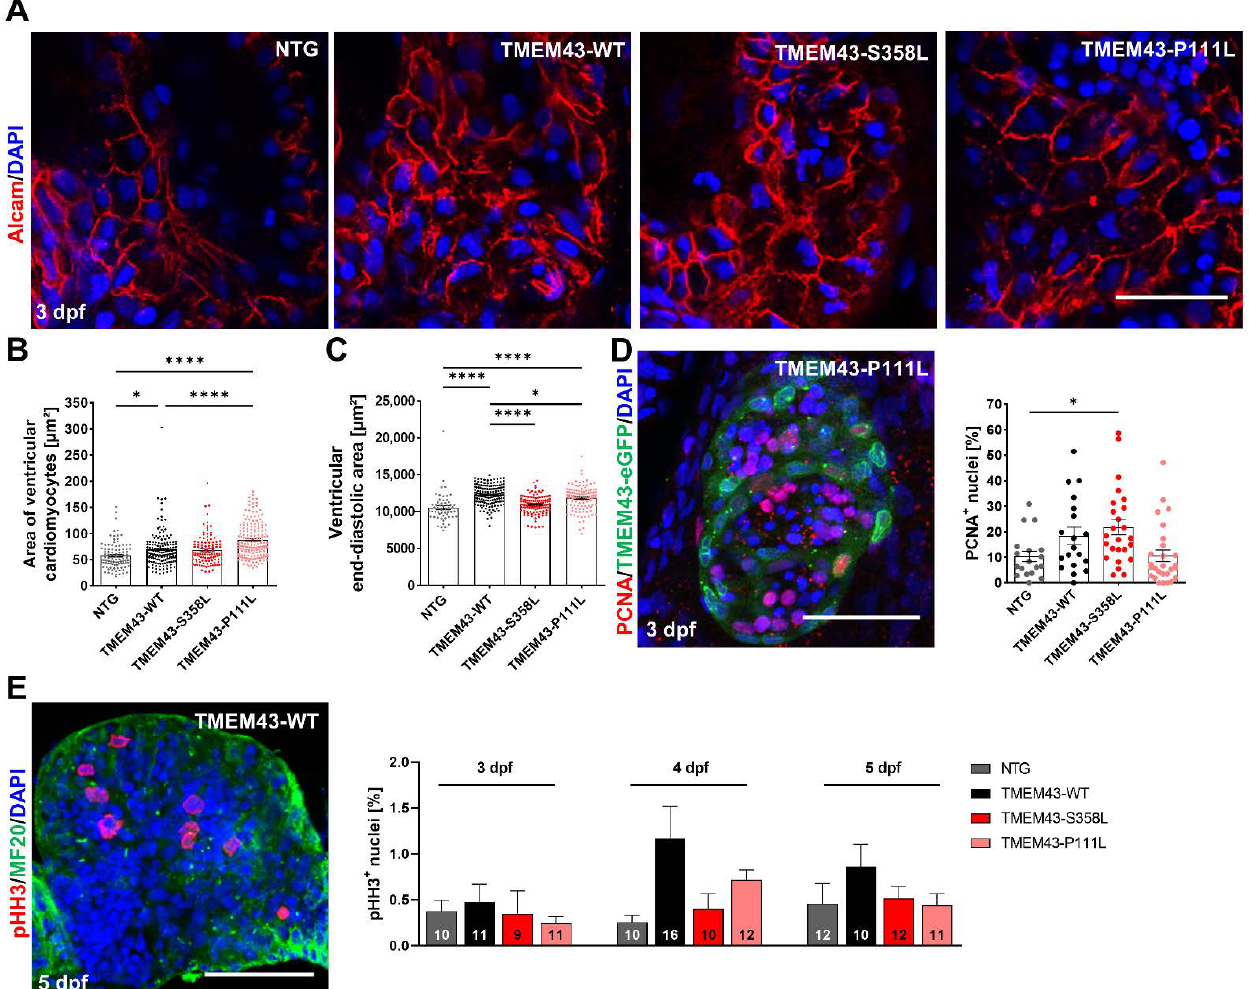
Figure 4 . Cardiac overexpression of stably folded TMEM43 leads to hypertrophic ventricular growth, but unchanged proliferation capacity in embryos. ( A ) Confocal maximum intensity projec- tions of 3 days post fertilization (dpf) hearts immunostained with DAPI (blue) and Alcam (red) to highlight plasma membranes. Scale bar = 30 µm. ( B ) Quantification of cardiomyocyte (CM) area represented in ( A ) reveals larger CMs in TMEM43-WT and TMEM43-P111L compared to non-trans- genic control (NTG) and TMEM43-S358L individuals (n ≥ 10 hearts per genotype). ( C ) Quantifica- tion of ventricular end-diastolic area shows the mean area of three individual sections of each fish from a time series of the embryonic cardiac cycle. Significantly increased end-diastolic ventricular areas were measured in TMEM43-WT and TMEM43-P111L compared to NTG and TMEM43-S358L individuals. ( D ) Representative confocal maximum intensity projection of a heart immunostained with PCNA (red), GFP (green), and DAPI (blue) at 3 dpf. Scale bar = 50 µm. In the graph, individual data points represent the percentage of PCNA + nuclei in the ventricle of each fish (n ≥ 18 individuals per genotype). A slightly increased proliferation rate was observed in the TMEM43-S358L trans- genic line compared to NTG. ( E ) Representative maximum intensity projection of a dissected heart immunostained with pHH3 (red), MF20 (targeting MYH1E; green) and DAPI (blue) at 5 dpf. Scale bar = 50 µm. The graph displays the mean percentage of pHH3 + cell nuclei for each genotype at 3 dpf, 4 dpf, and 5 dpf. The number of analyzed hearts per condition are indicated at the bottom of the columns. ( B – E ) For all graphs, significance was determined by one-way ANOVA with Bonfer- roni’s multiple comparison test, * p ≤ 0.05, **** p ≤ 0.0001. Error bars correspond to SEM. To further determine the effect of TMEM43-WT and TMEM43 variants on adult hearts, we examined heart morphology in >5-month-old fish. Male and female TMEM43 transgenic zebrafish survived until adulthood. Quantification of the ventricular area of